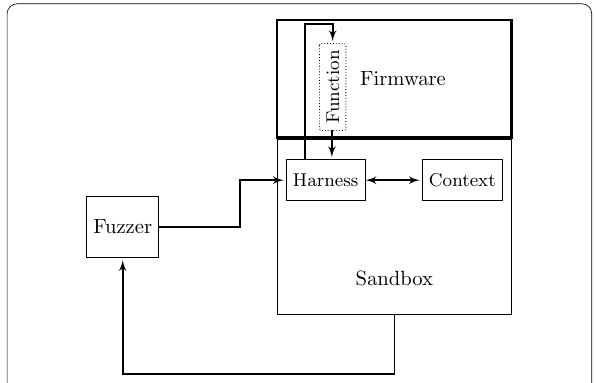
Fig. 7 Scheme of embedded fuzzing through sandbox